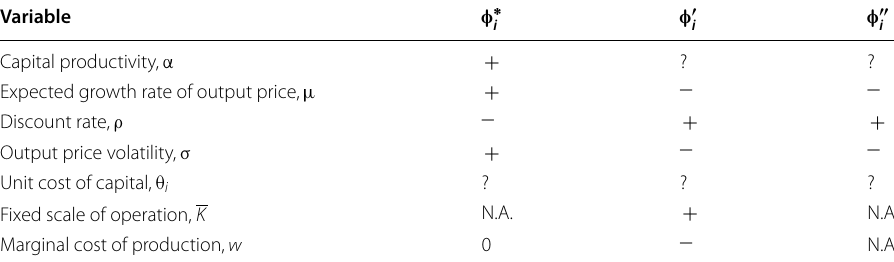
Table 1 Summary of the comparison of the optimal royalty rate across three investment types and the effect on the optimal royalty rate of increasing one variable when all others remain fixed